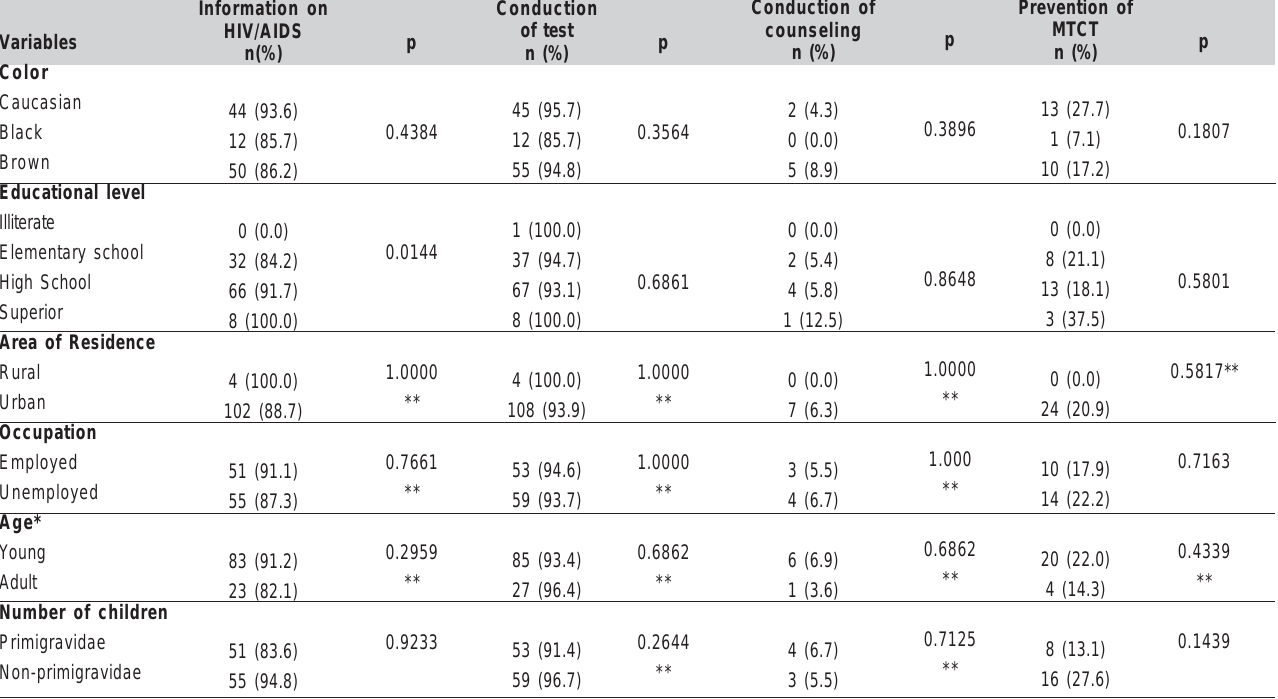
Table 3 – Numeric and percentage distribution of positive answers given by pregnant women about information on HIV/AIDS, conduction of tests and counseling and prevention of MTCT, according to some social, economical and demographic